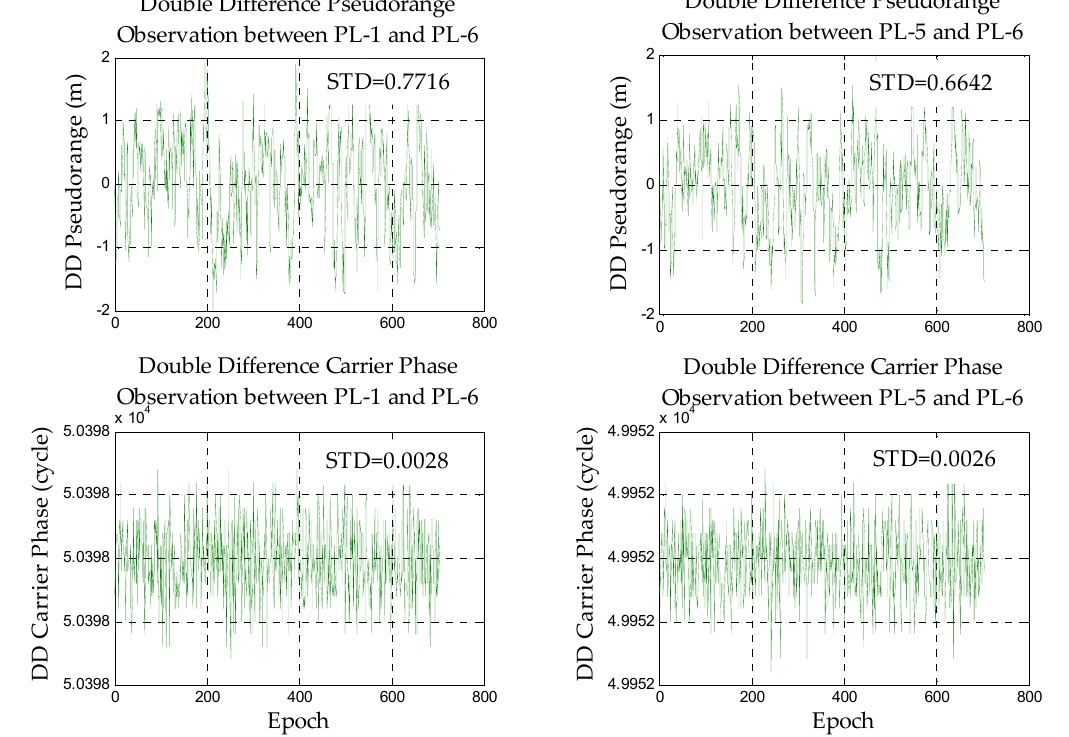
Figure 4. The double difference observations in the zero baseline.